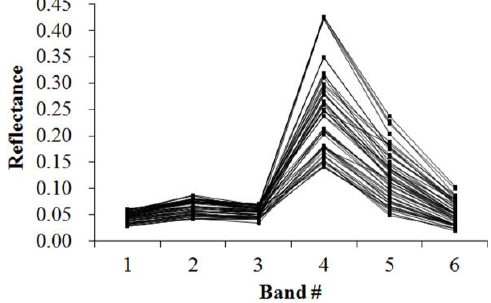
Figure 6. Spectral curves collected from samples used to determine Table 4. Table 4. Identification template 2 for cropland class.